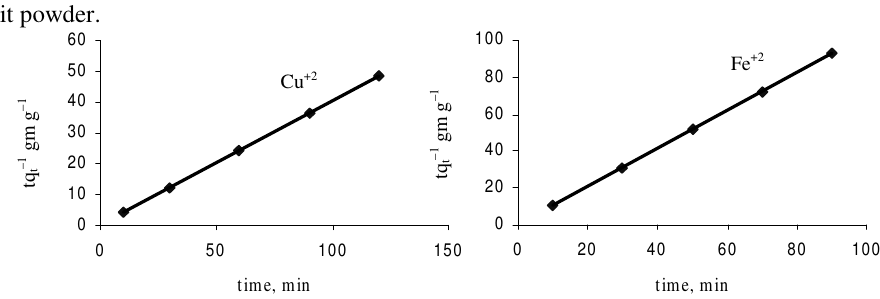
– q ) for adsorption of ferrous and copper ions on pine e t